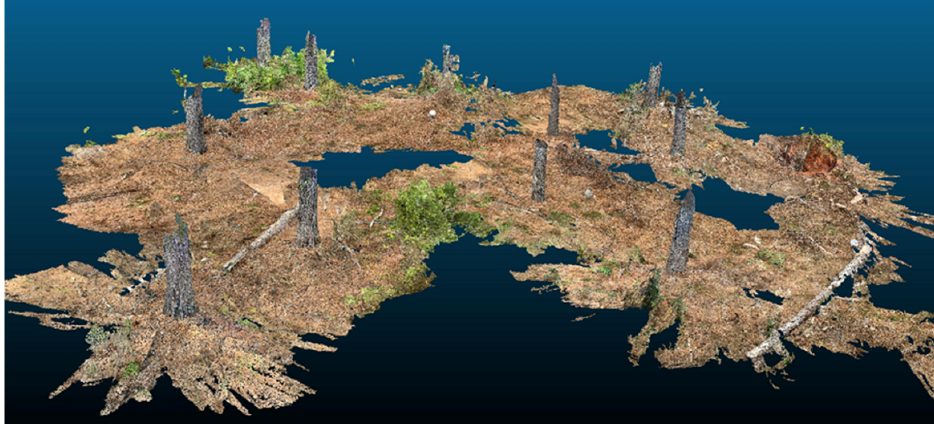
Figure 6. iPad LiDAR scanning error with one tree appearing as two separate trees.